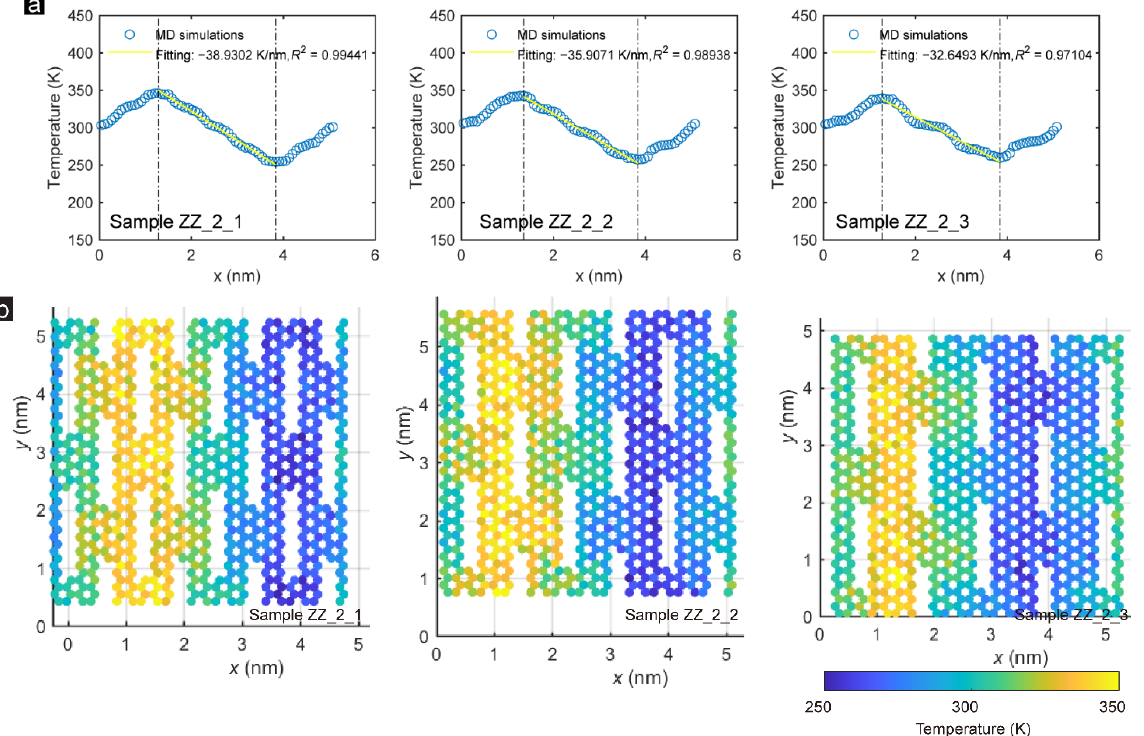
Figure 4. ( a ) Time-averaged temperature distribution of each atom along the direction perpendicu- lar to the zigzag-incised GK incisions (Sample ZZ_2_1, Sample ZZ_2_2, and Sample ZZ_2_3) during the simulation process. ( b ) Snapshots of the temperature distributions of Sample ZZ_2_1, Sample ZZ_2_2, and Sample ZZ_2_3 after one nanosecond of heat conduction.